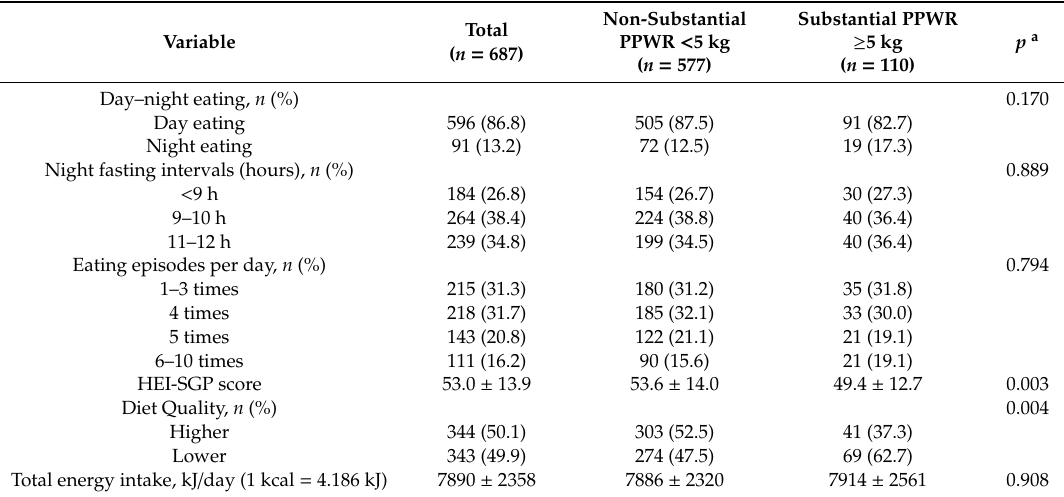
Table 2. Eating patterns and total energy intake of pregnant women at 26–28 weeks’ gestation from the GUSTO